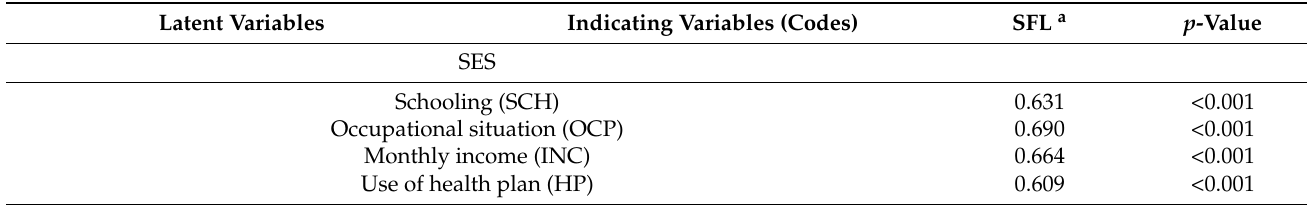
Table 2. Standardized factor loads of the measuring models of socioeconomic status, intolerance